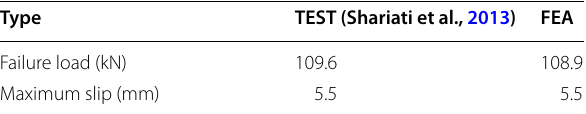
Table 4 Mahdi test results and simulation results.